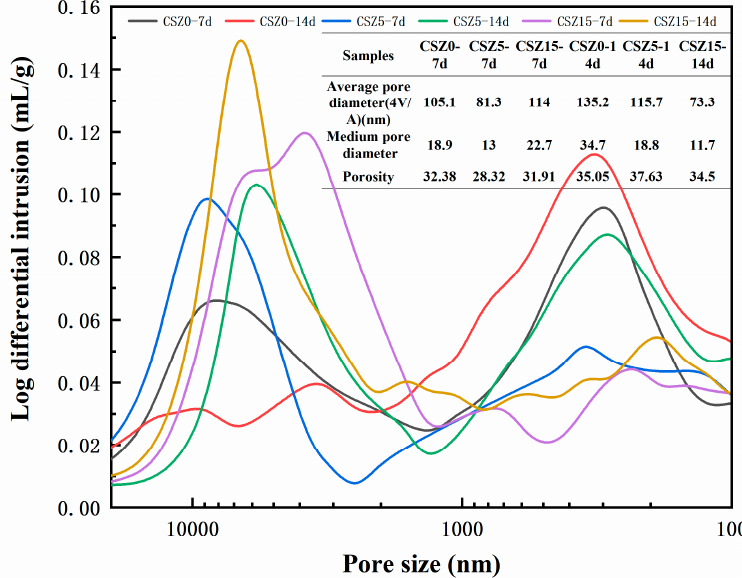
Figure 10. Pore size distribution of CSZ specimens after different hydration curing time and then 2 h